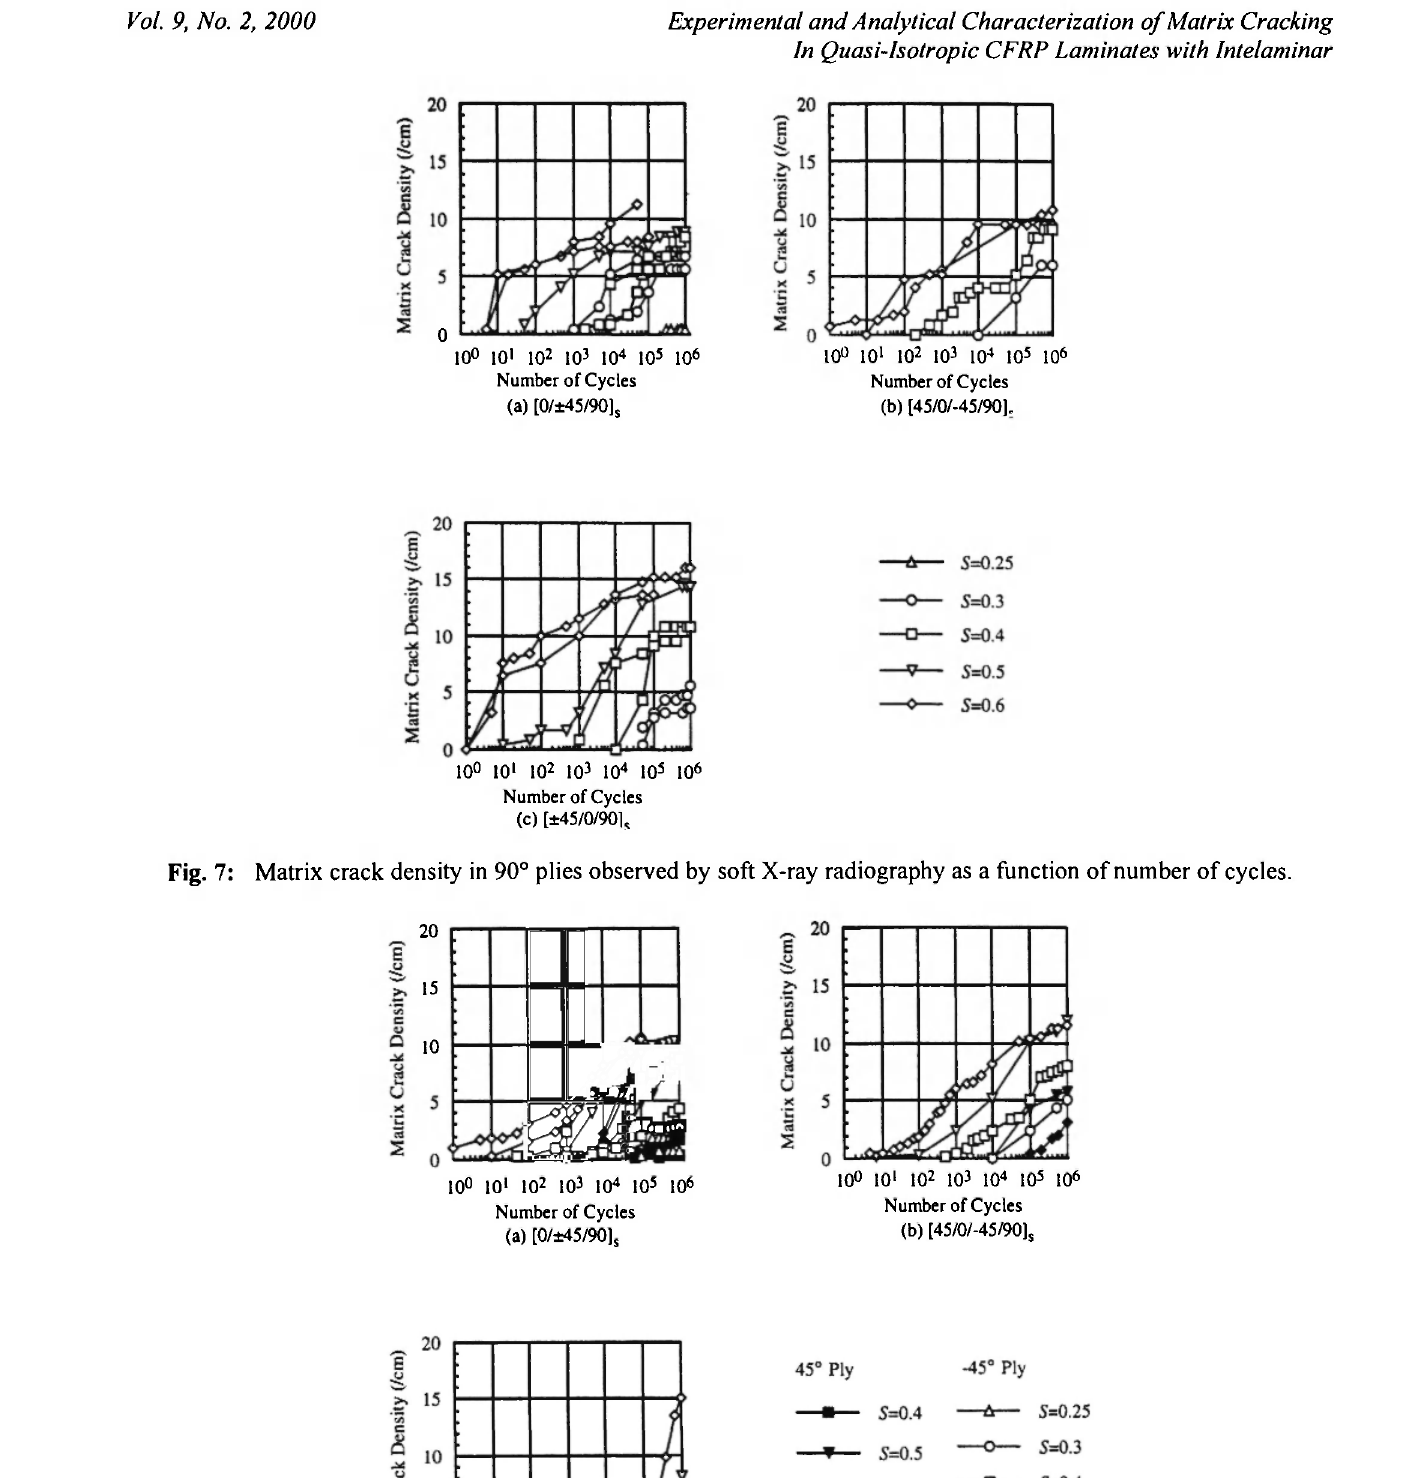
Fig 8: . Matrix crack density in ±45° plies observed by optical microscope as a function of number of